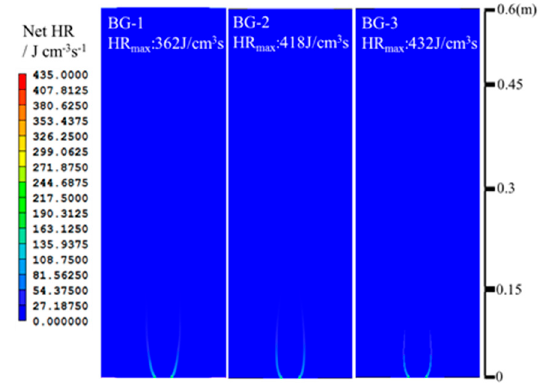
Figure 3. Effect of CH 4 content in biogas fuel on combustion temperature distribution.